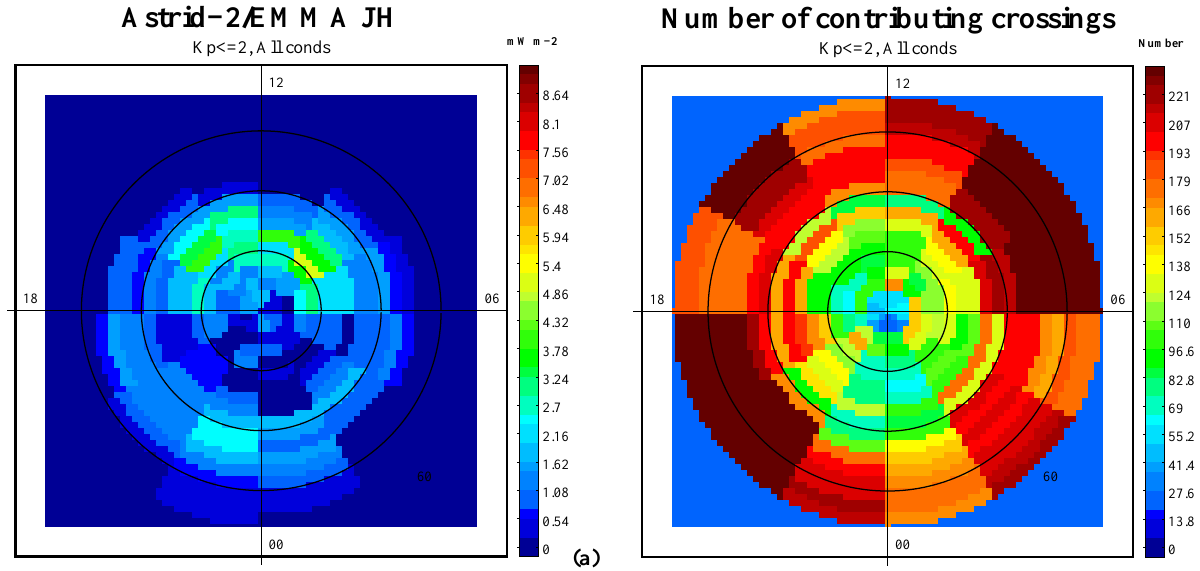
Fig. 2. The average Joule heating for ILAT 55–90 for K p ≤ 2, all MLT (left). MLT 12, 18, 24 and 06 are shown in the plot. The inner circle corresponds to ILAT 80. The Joule heating is correlated with the auroral zone and in the dayside the intense Joule heating is related to the cusp region. In the right subplot the corresponding orbital coverage (number of auroral crossings contributing to each bin) is shown.